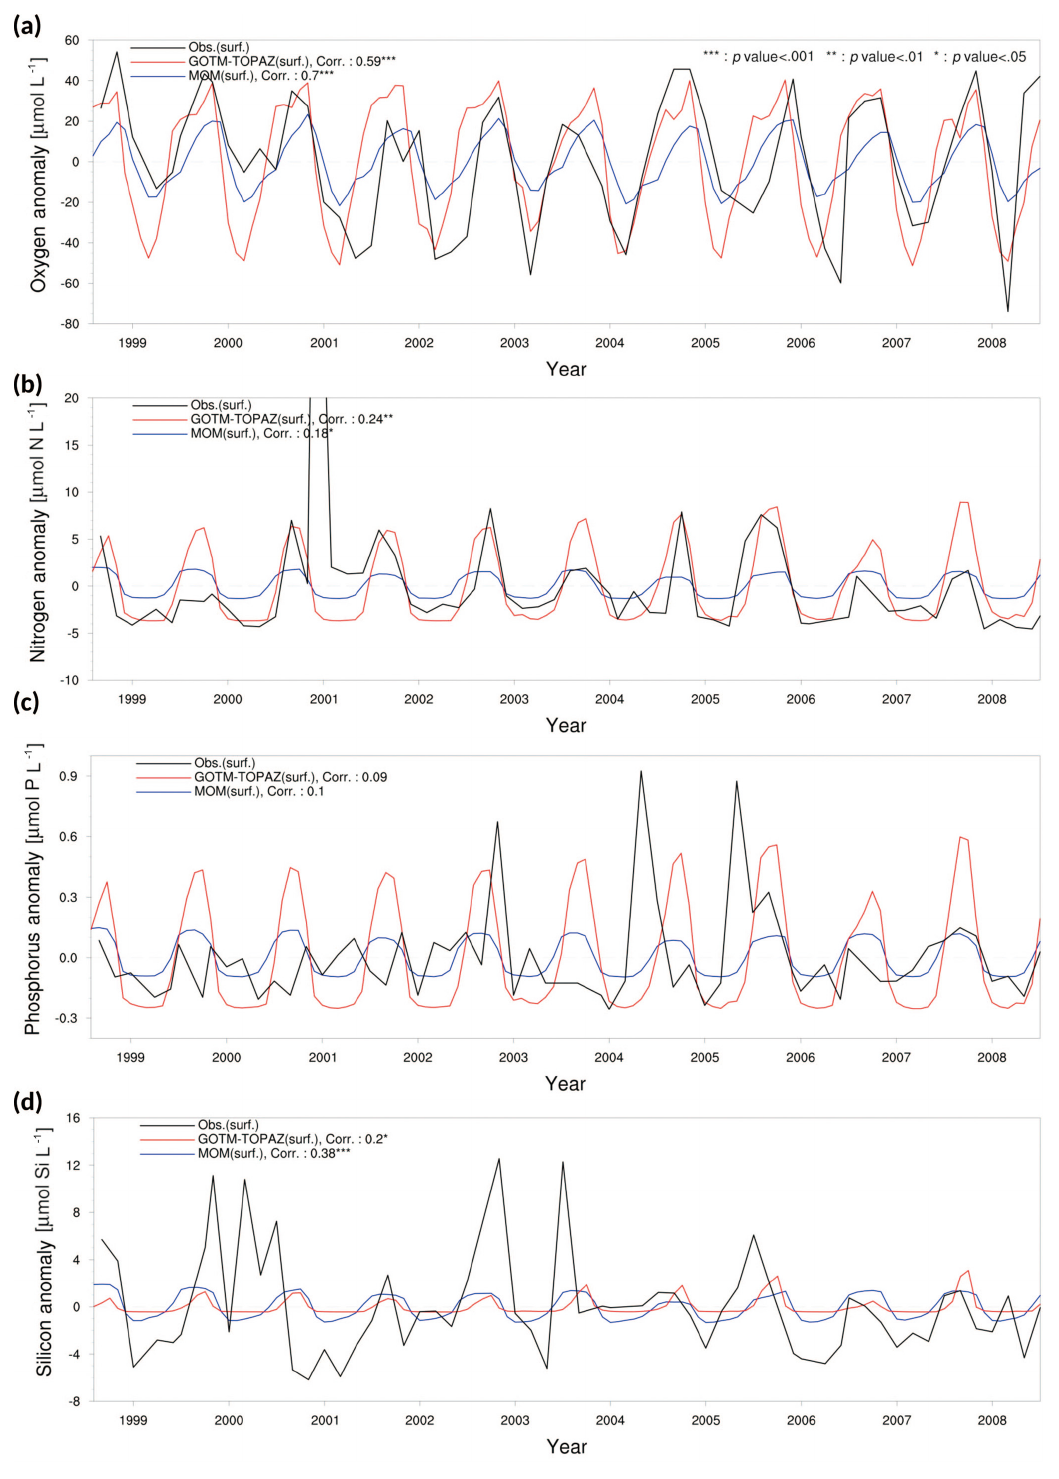
Figure 7. Anomaly time series and correlation values from observational data (black lines), MOM results (blue lines), and GOTM–TOPAZ results (red lines) for concentrations of (a) dissolved oxygen, (b) nitrogen, (c) phosphorus, and (d) silicon at point 102 for the 10-year period of 1999–2008; in this figure, nitrogen, phosphorus, and silicon include NO 3 , PO 4 , and SIO 4 ,